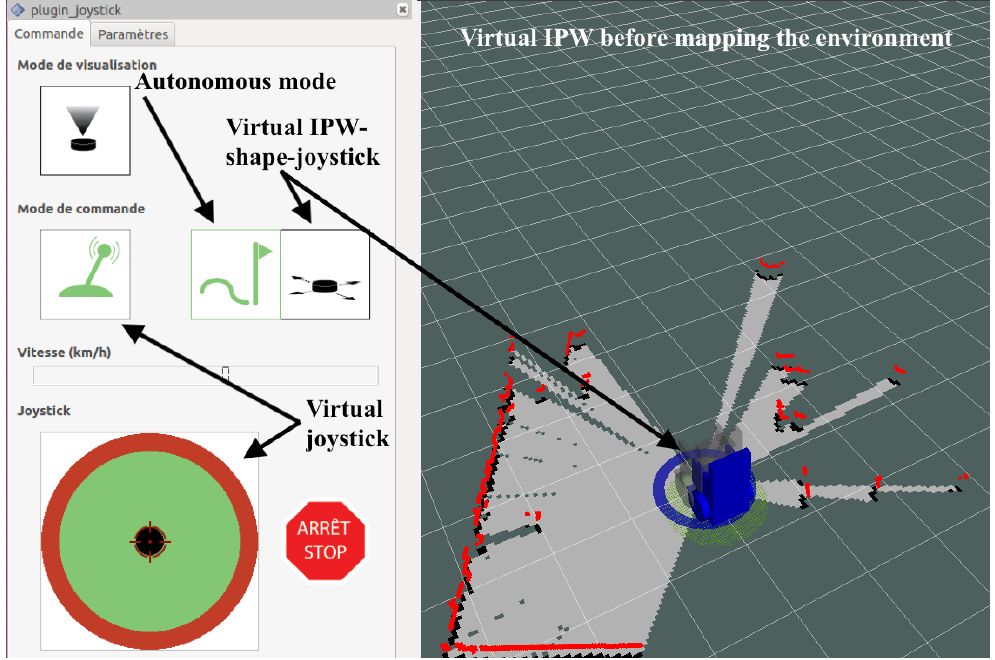
Figure 1. Graphical interface present on the IPW’s touch screen tablet when first starting the IPW.